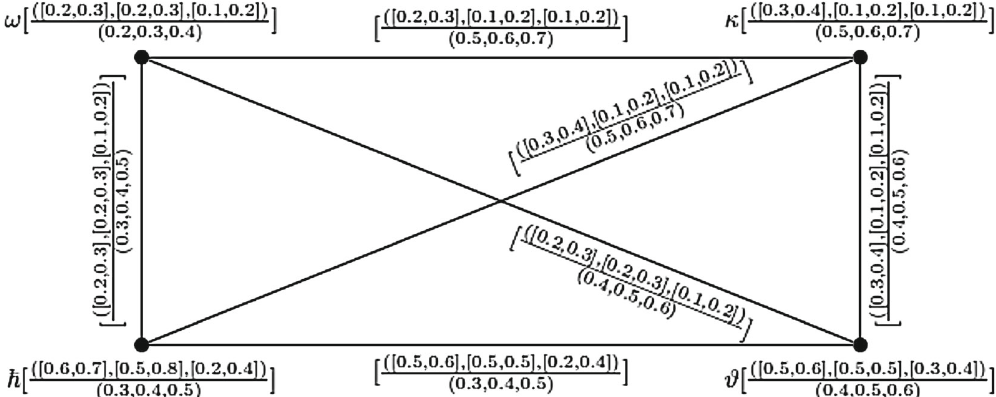
Figure 2: Complete 3pC graph.